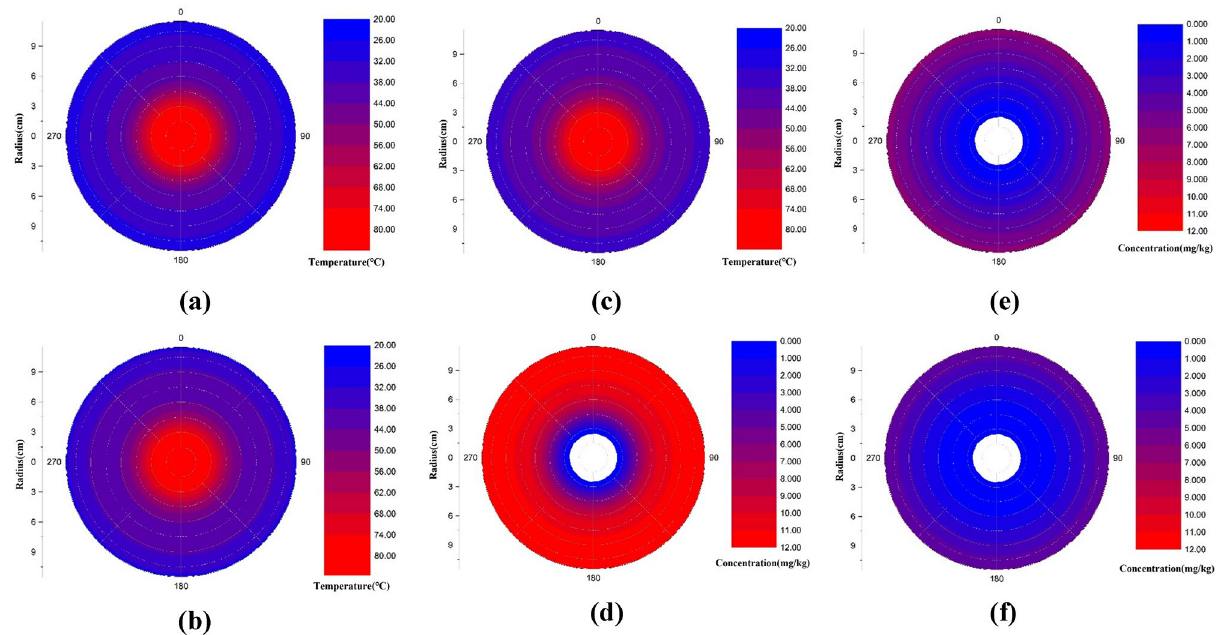
Figure 6. Temperature ( a – c ) and concentration ( d – f )